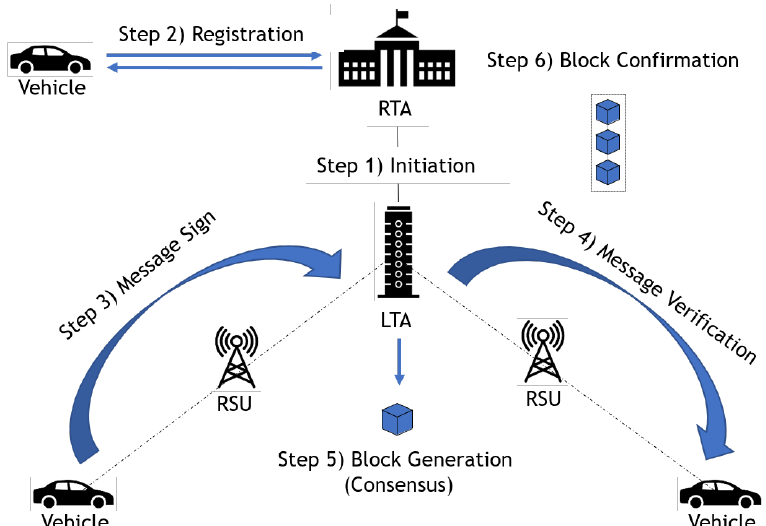
Figure 6. Entire message authentication process.